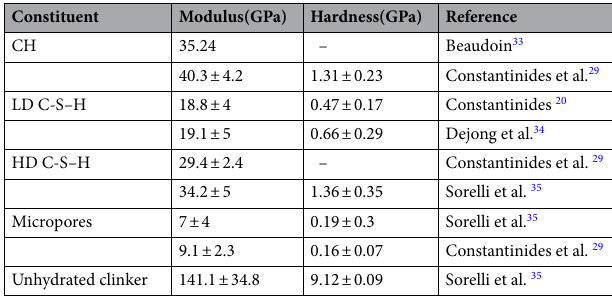
Table 2. Intrinsic elastic properties of cement paste constituents.